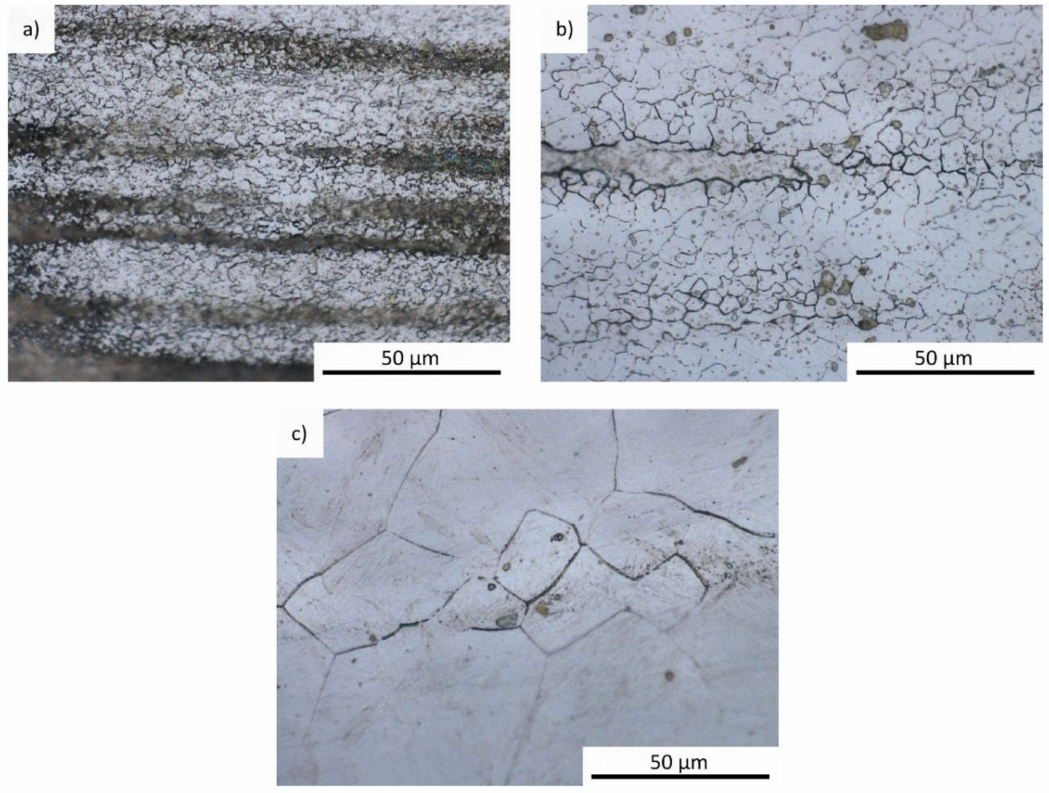
Figure 23. Prior austenitic grains in variously deformed samples. ( a ) temperature 770 ◦ C, strain rate